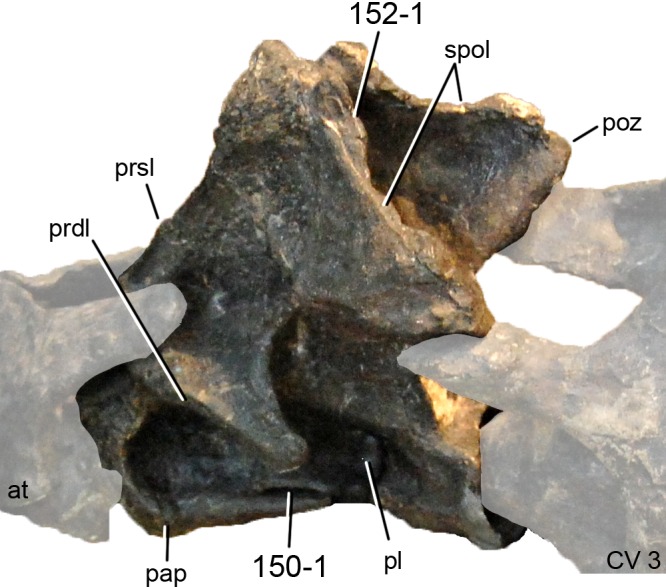
Axis of Diplodocus carnegii CM 84 in posterolateral view.Note the pneumatic slot-like fossa posterior to the parapophysis (C150-1), and the presence of a postspinal lamina (C152-1). Abb.: at, atlas; CV 3, cervical vertebra 3; pap, parapophysis; pl, pleurocoel; poz, postzygapophysis; prdl, prezygodiapophyseal lamina; prsl, prespinal lamina; spol, spinopostzygapophyseal lamina.